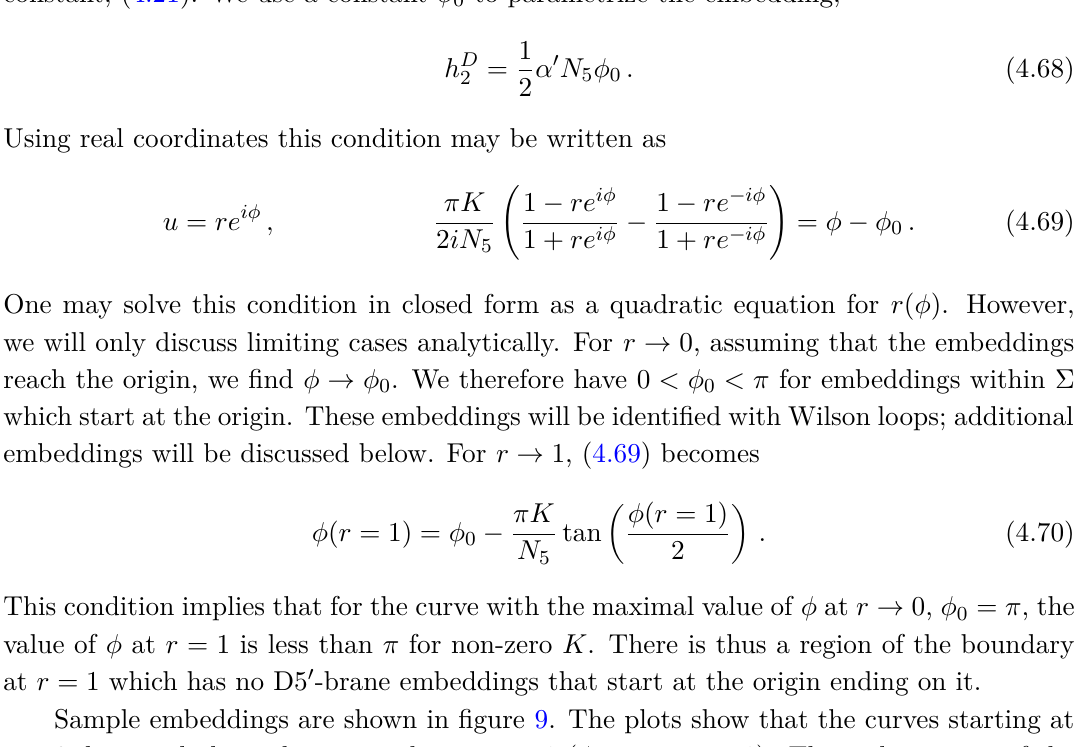
Figure 9. Wilson loop embeddings from left to right for K/N 5 ∈ { 1 at u = 0 / u = i . The semi-infinite D3-branes emerge at u = − 1 . The curves ending at the NS5 pole correspond to φ 0 in the range (0 , π ) and represent Wilson loop embeddings. The curves reaching to the AdS 5 × S 5 region emerging at u = − 1 correspond to surface operator embeddings associated with the N = 4 SYM node; they have φ 0 > π